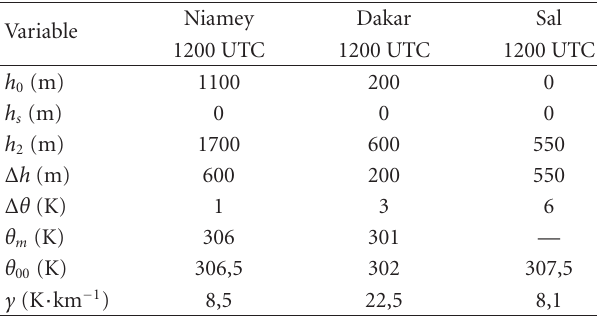
Table 2: Characteristic parameters of continental (Niamey), coastal (Dakar), and marine (Sal) boundary layers at 1200 UTC for respective case